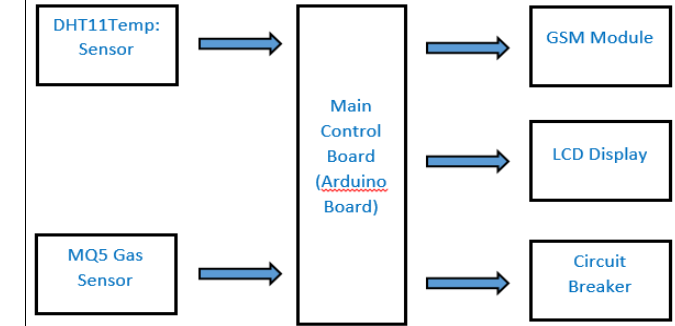
Figure 5: Block diagram of the home fire alert system.